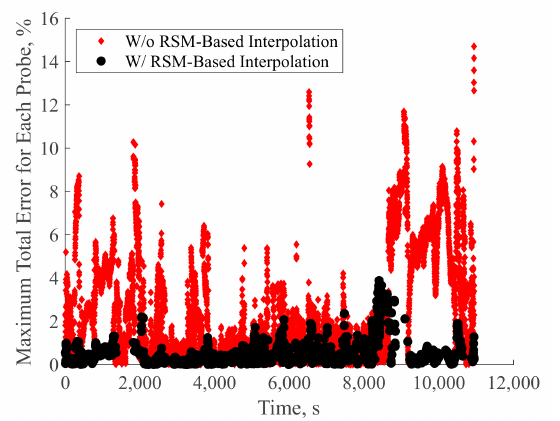
Figure 9. Maximum percentage uncertainty for all pitot probes for all measured flight cases caused by interpolation.